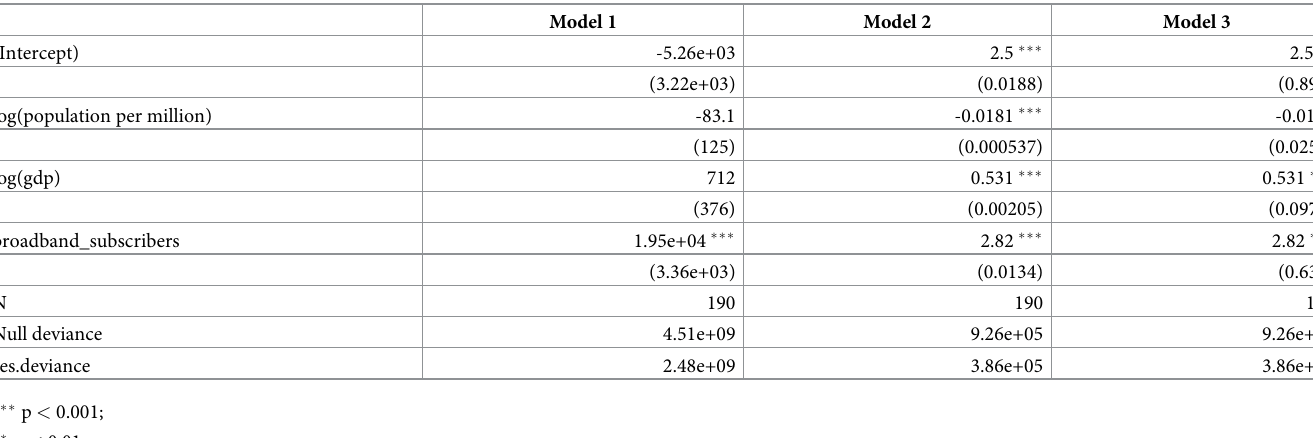
Table 2. Global models I. (DV: download per